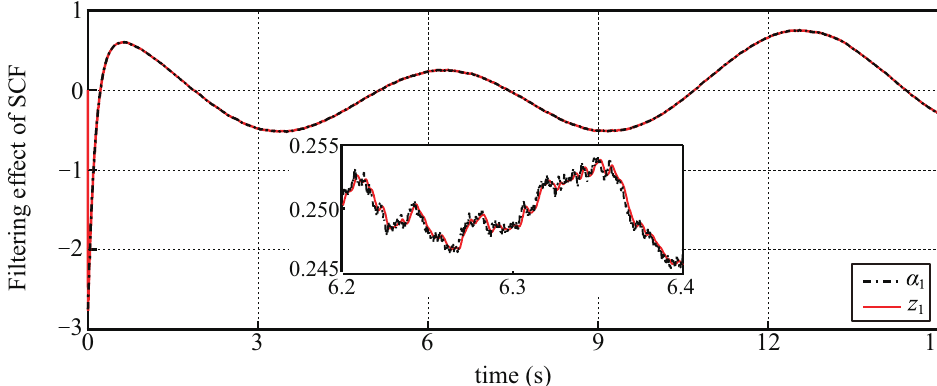
Figure 8. Filtering performance of the SCF with α 1 being the input and z 1 being the